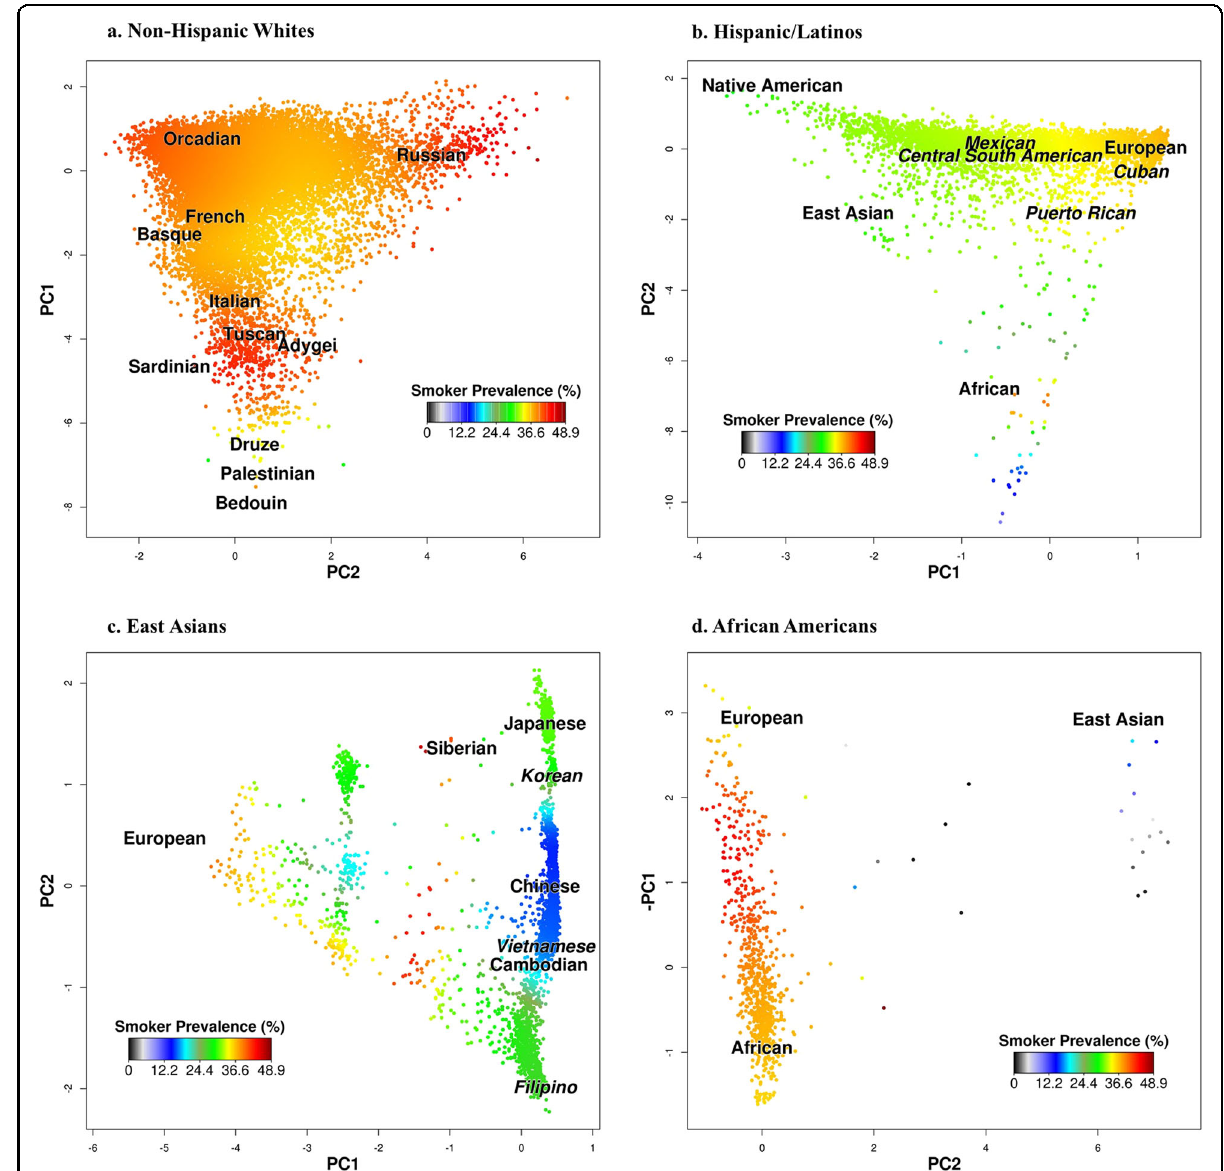
Fig. 1 Smoking Initiation Prevalence vs. Genetic Ancestry. Plots of smoking initiation prevalence vs. genetic ancestry in GERA: ( a ) non-Hispanic whites, ( b ) Hispanic/Latinos, ( c ) East Asians, and ( d ) African Americans. Human Genome Diversity Panel populations are plotted at their relative